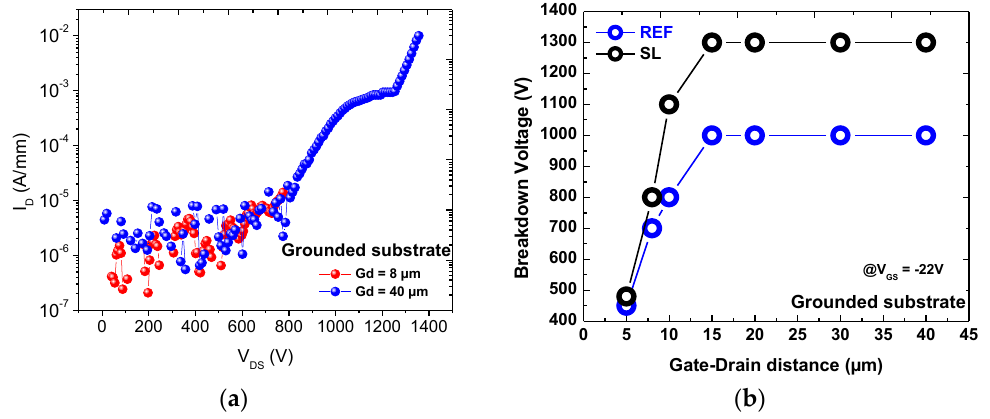
Figure 4. Three-terminal breakdown voltage with grounded substrate at room temperature ( a ) for device with SL and ( b ) for several gate-drain distances black curve (with SL) and blue curve (without SL).